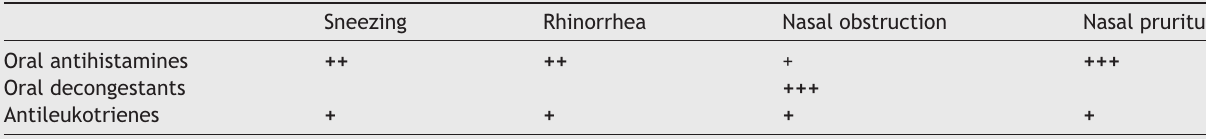
Effect of medications on allergic rhinitis symptoms. Sneezing